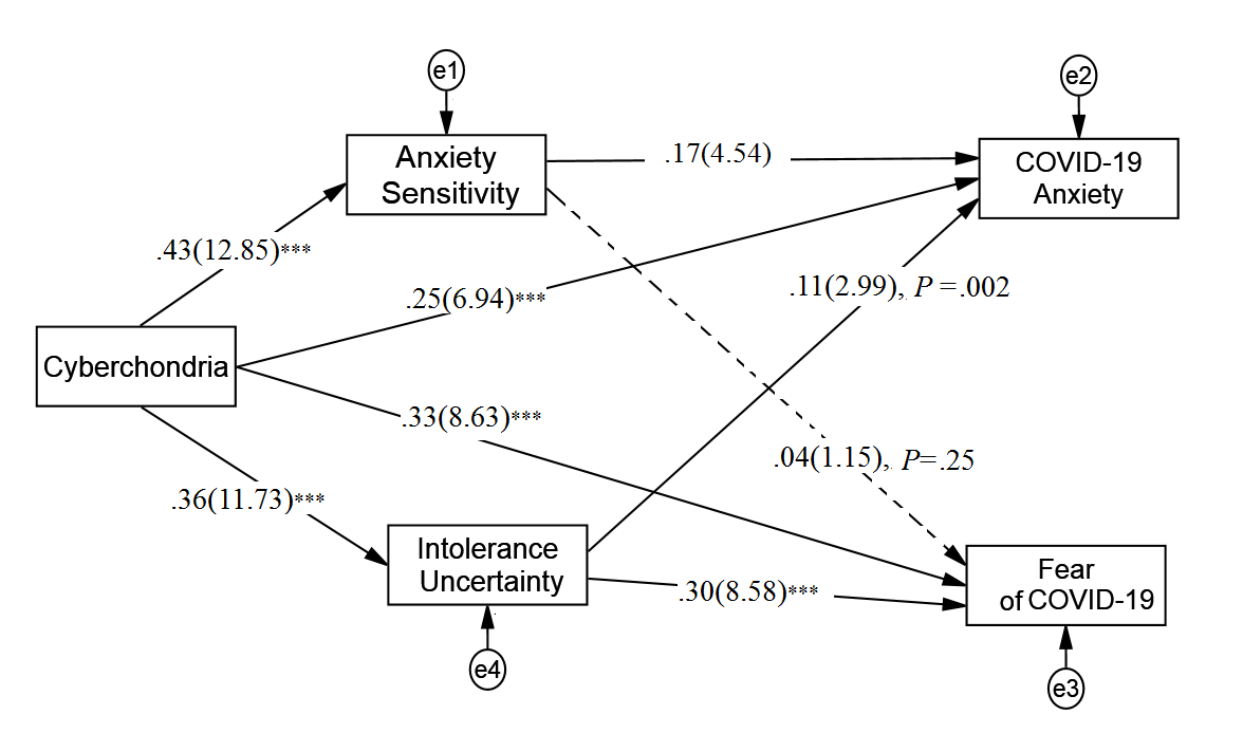
Figure 2. The reciprocal multiple mediation model. Path coefficient: standardized coefficient ( t value), dash line: nonsignificant path. *** P <.001 level (two-tailed).